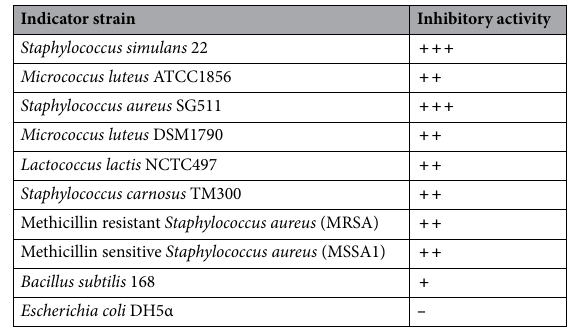
Table 3. Antimicrobial susceptibility of homicorcin against different indicator strains. Symbols represented as “ + + + ”, significant inhibition; “ + + ”, moderate inhibition; “ + ”, low inhibition and “–”, no inhibition.